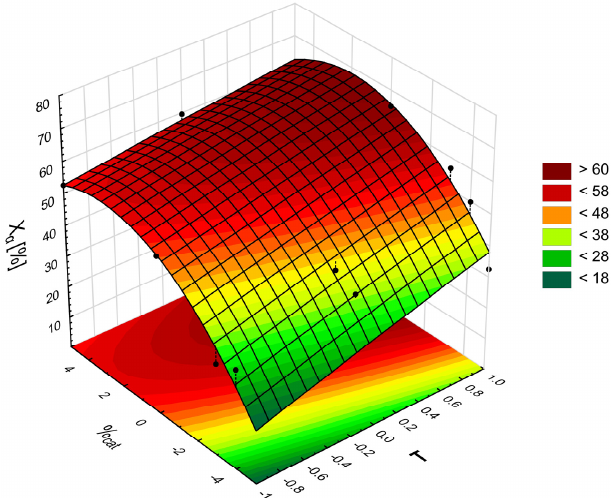
Figure 9. The of X β NMR variability depending on the reaction temperature (T) and the catalyst content (% cat ).